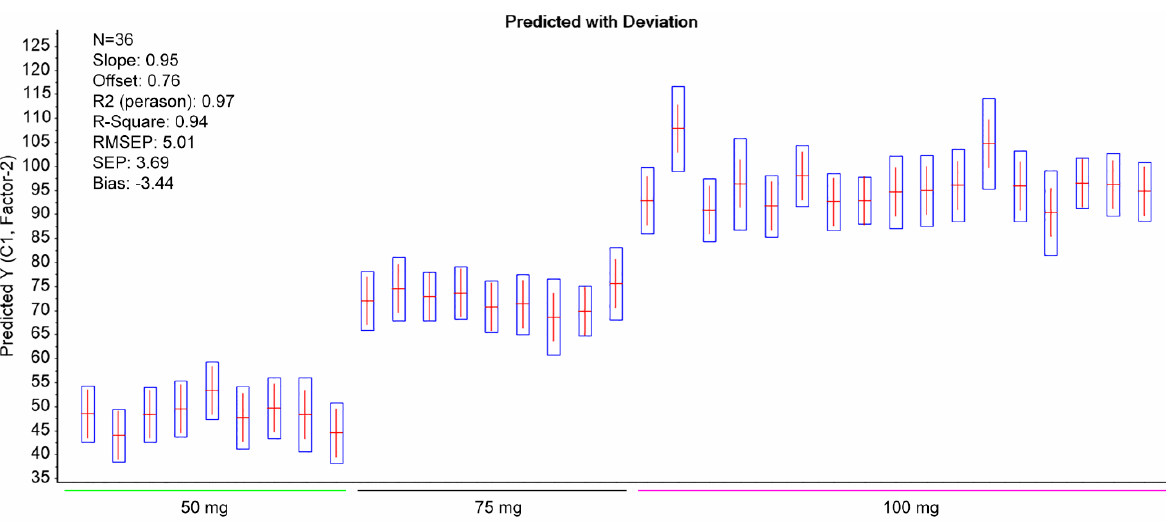
Figure 5. Leave-one-out CV results (blue: training set, red: validation set).